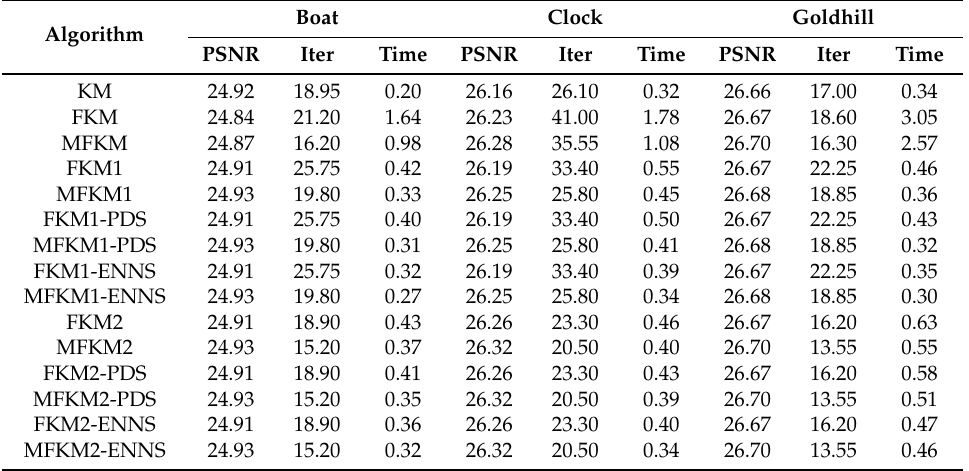
Table 3. PSNR (in dB), number of iterations and codebook design time (in seconds) for images Boat, Clock and Goldhill, using N = 32.